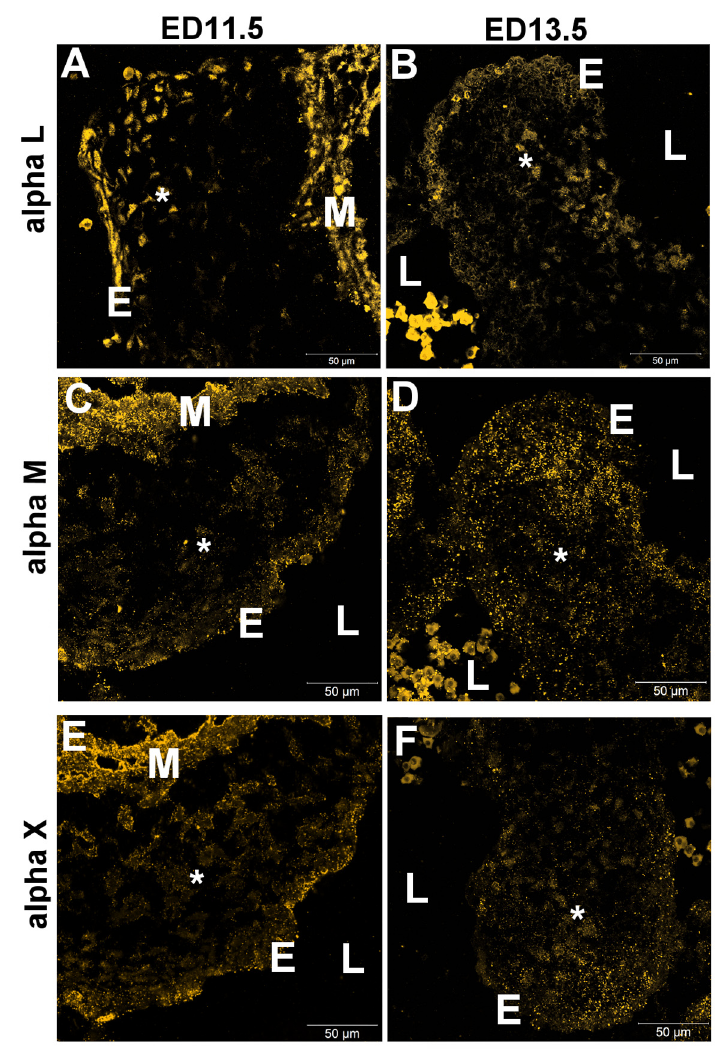
Figure 3. Immunofluorescent localization of the α integrin subunit partners of β2 integrin in embryonic mouse hearts. Sections of ED11.5 (A,C,E) and ED13.5 (B,D,F) mouse hearts were immunolabeled with antibodies against specific α integrin subunits: A,B , αL (CD11a); C,D , αM (CD11b); E,F , αX (CD11c). No immunostaining was observed in control sections in which the primary antibody was omitted (data not shown). Incubation of sections of mouse thymus with each of these α integrin antibodies (data not shown) displayed